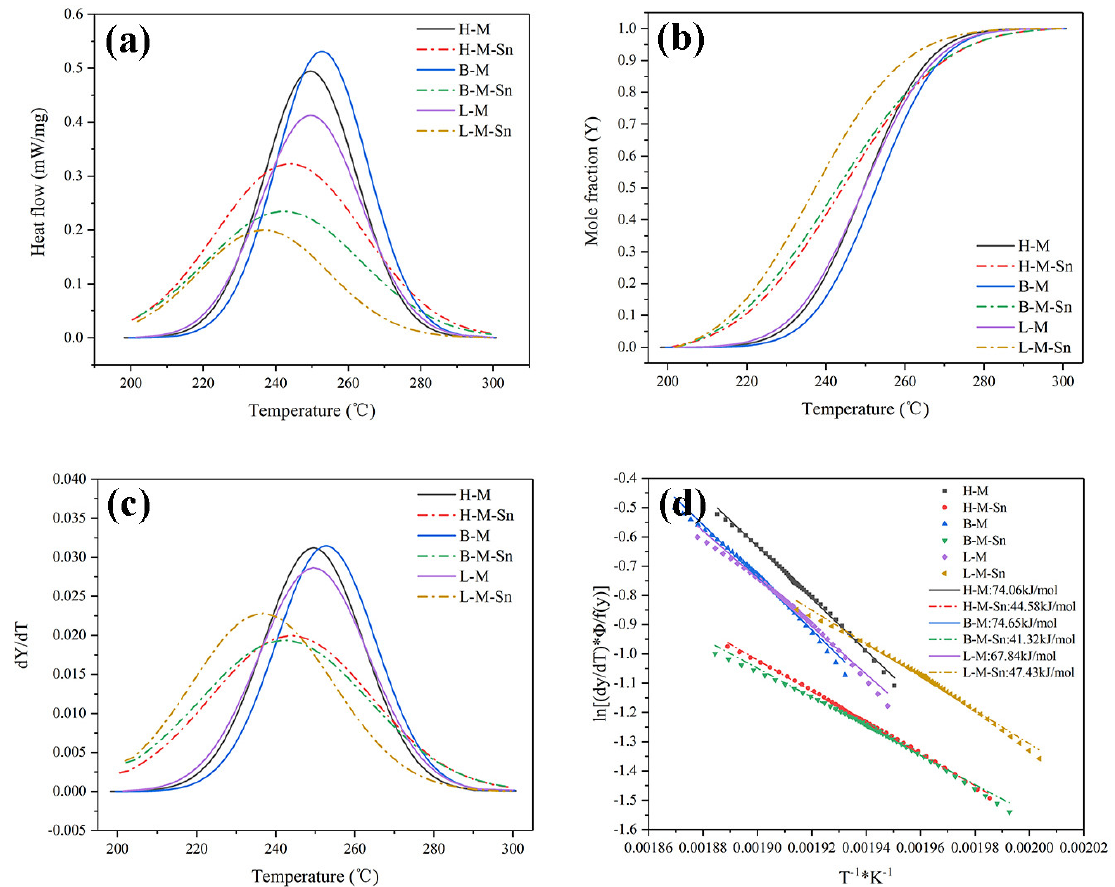
Figure 7. Calculation of precipitation activation energy of β ” precipitates of as-quenched alloys: ( a ) precipitation peak of β ” precipitates, ( b ) Y-T, ( c ) ( dY / dT ) − T , ( d ) ln [( dY / dT ) * Φ / f ( Y )] − 1 / T